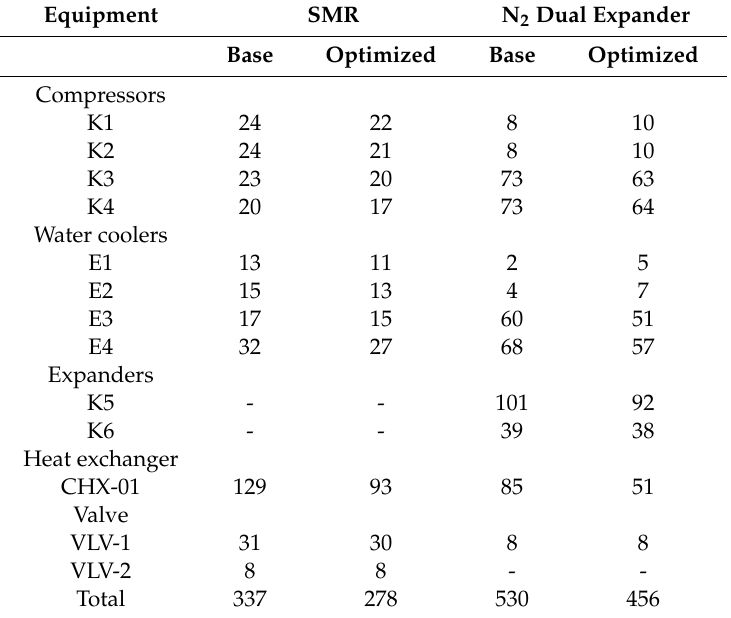
Table 12. Exergy destruction values for SMR and N 2 dual expander LNG processes (values in W).